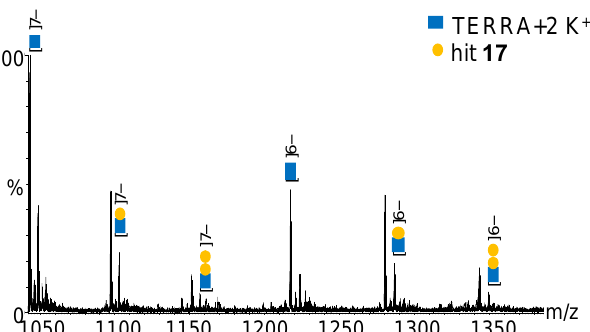
Figure 5. The MS spectra of TERRA (blue squares) incubated with the indicated hits . Samples con- taining TERRA oligonucleotide (5 µM) and hit molecule (10 μM) were incubated in MS buffer (HFIP 120 mM/TEA pH 7.4, KCl 0.8 mM, isopropanol 20%) overnight before MS analysis. A zoom on the most significant m/z range is shown. The larger m/z range is provided in Figure S11.